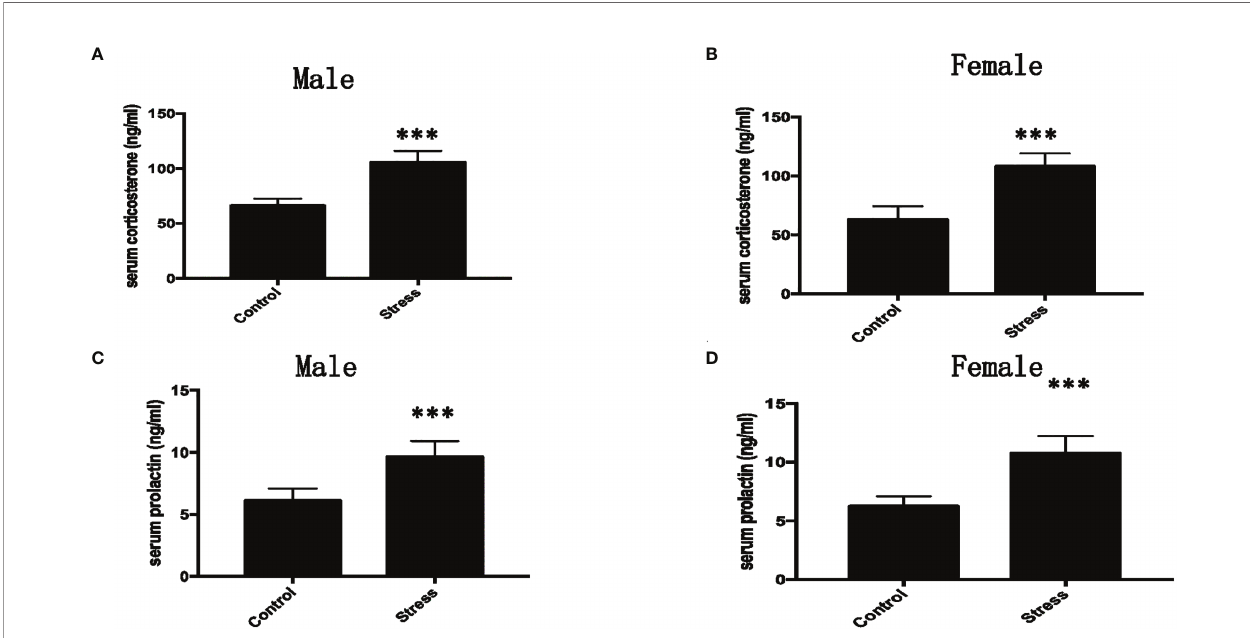
FIGURE 4 | The effect of chronic restraint stress on serum cortisol and prolactin. (A) Cortisol in male mice; (B) Cortisol in female mice; (C) Prolactin in male mice; (D) Prolactin in female mice. control: control group, stress: restraint stress group. n=10. ***Represents the comparison with the control group,